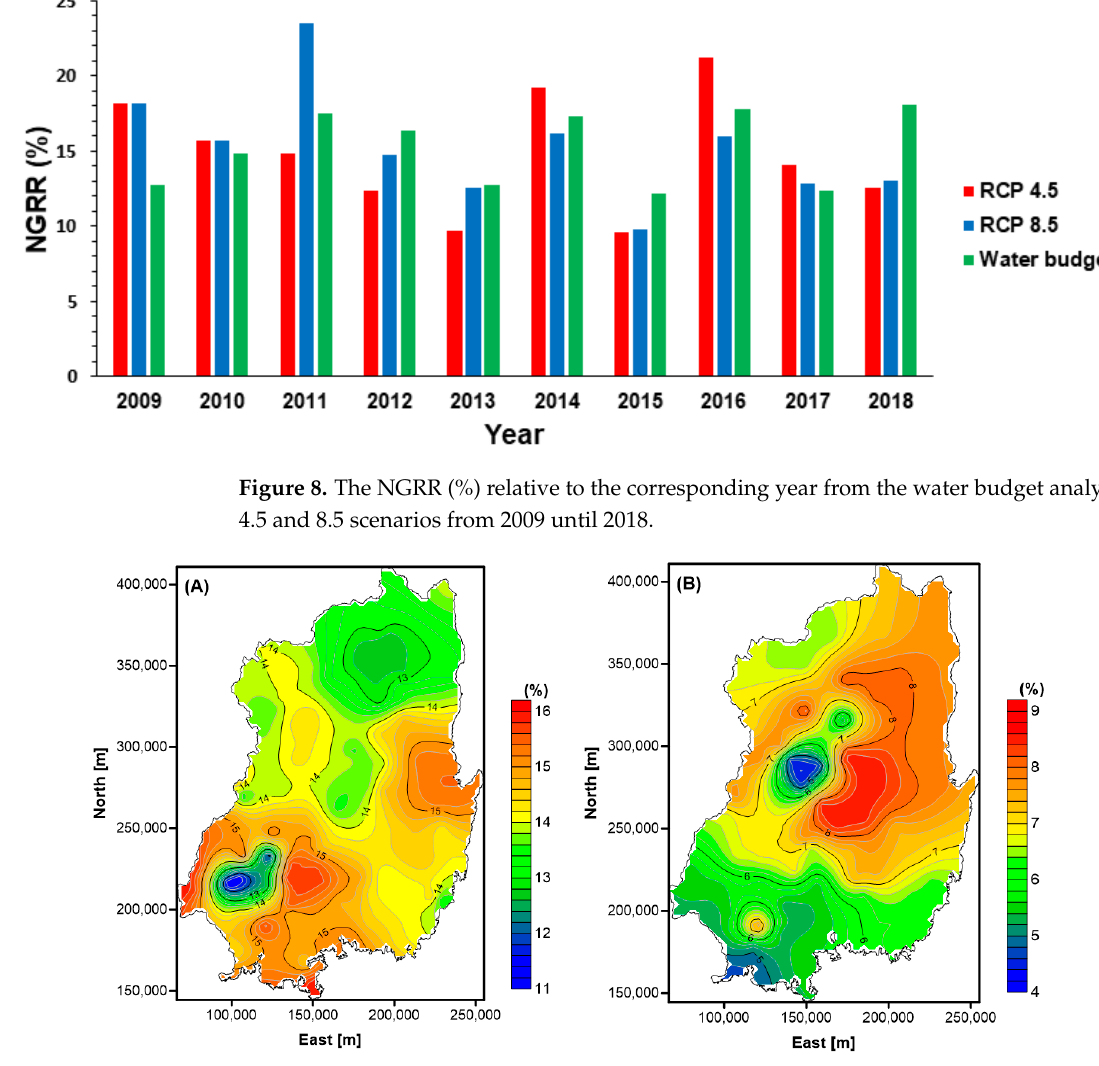
Figure 9. Distribution map of the average NGRRs in the Nakdong River watershed by ( A ) the water budget analysis of the period 2009–2018 and ( B ) the RCP 4.5 scenario in